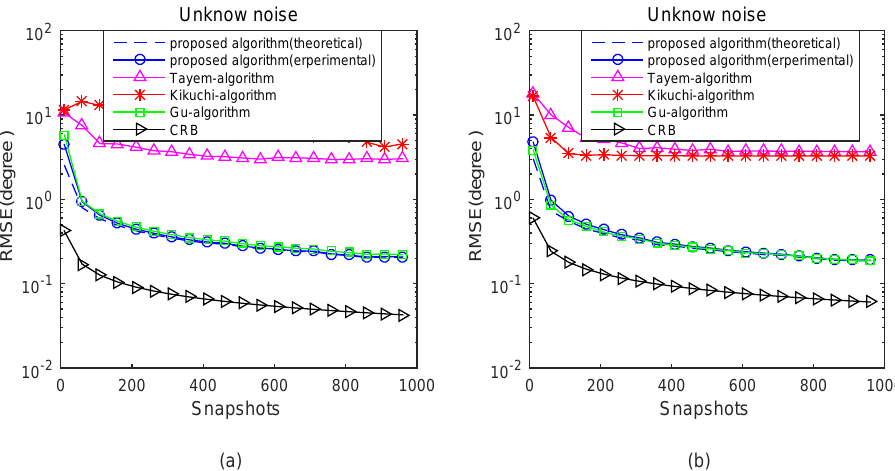
Figure 8. RMSE versus Snapshots in an unknown noise situation.( a ) s 1 ( t ) ; and ( b ) s 2 ( t )